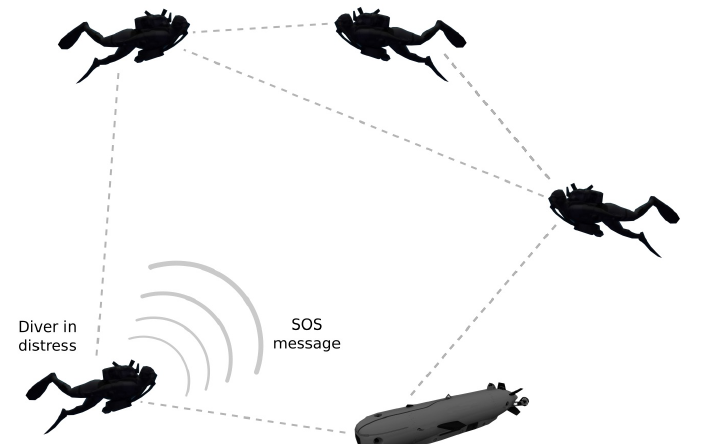
Figure 1. Illustration of system